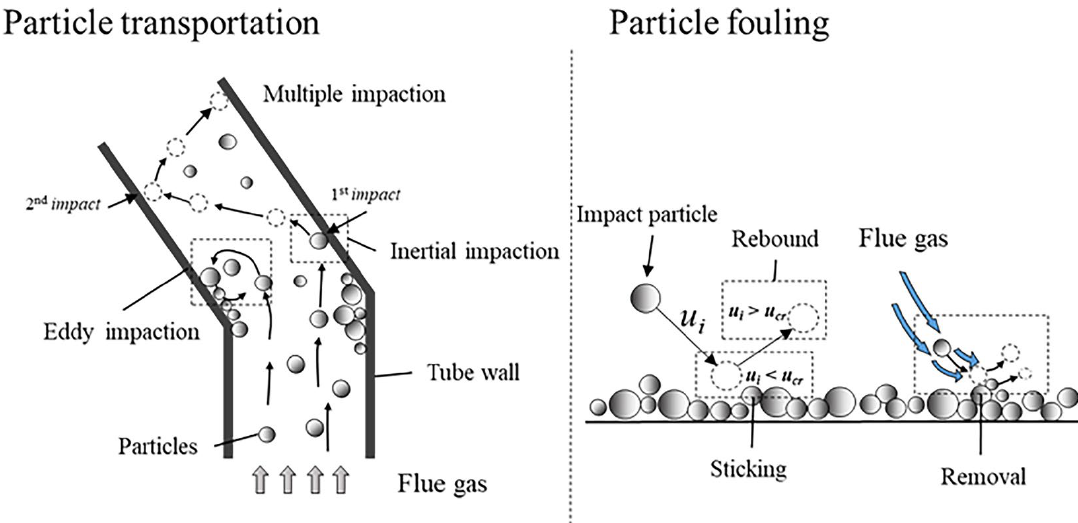
Figure 3. Schematic diagram of particle transportation and fouling formation.